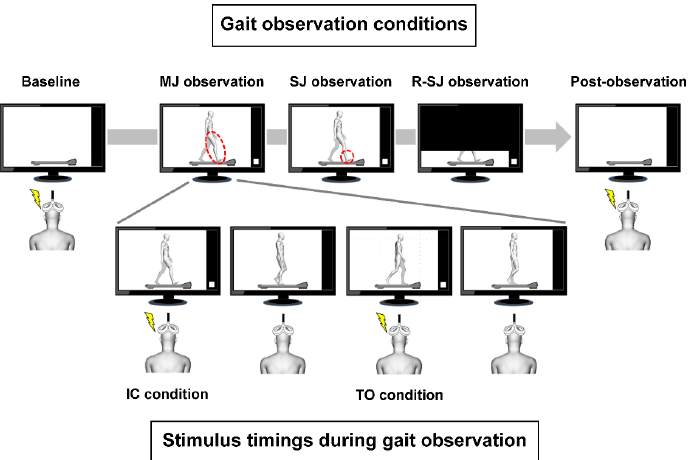
Figure 1. Stimulus timings during gait observation and experimental conditions. The walker’s right and left legs are presented in white and gray color, respectively. The white squares in the monitors were used as trigger signals for magnetic stimulation. The transcranial magnetic stimula- tion was delivered to the observer at two different points of the gait cycle: when the walker’s right foot contacted the treadmill (initial contact (IC) condition) and when the right foot rose from the treadmill (toe-off (TO) condition). MEP measurements were conducted prior to and following gait observation (baseline and post-observation conditions, respectively), and repeated during the three types of gait observation conditions. The observers were asked to closely observe the walker’s right lower limb movements in the multiple-joint (MJ) observation condition, the walker’s right ankle joint movements in the single-joint (SJ) condition, and the walker’s right lower limb projected only below the knee joints in the restricted single-joint (R-SJ) condition. The red dotted lines indicate the body parts observed in each condition.